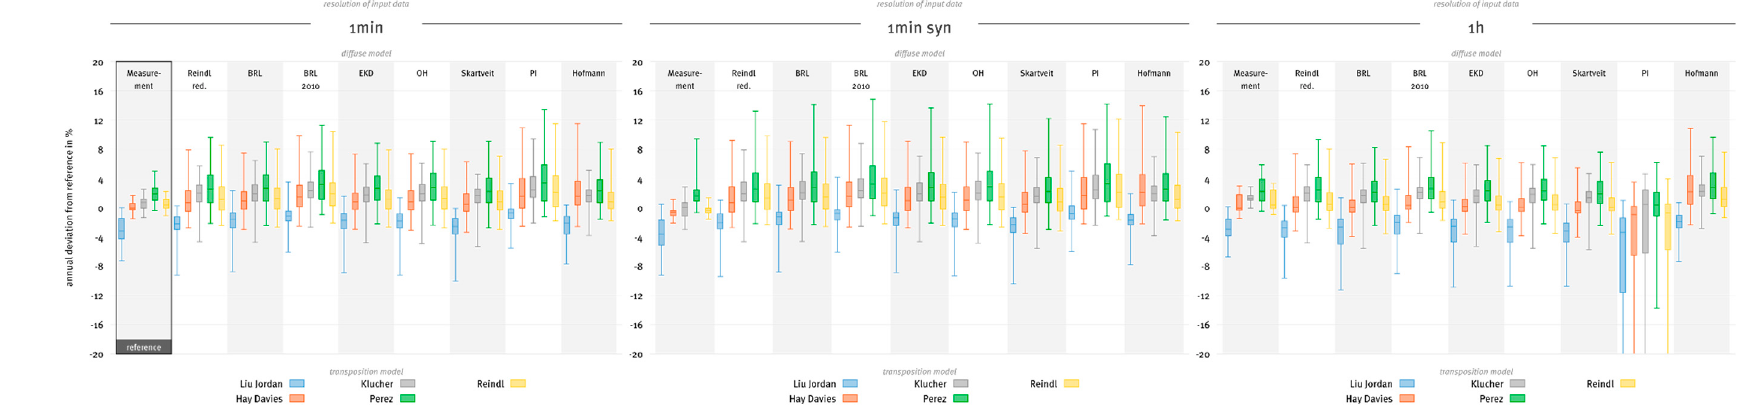
Figure A4. Same plot type as Figure A1, but with all results from all three module tilt modes. Note the different y scale in comparison to Figures A1 and A2.